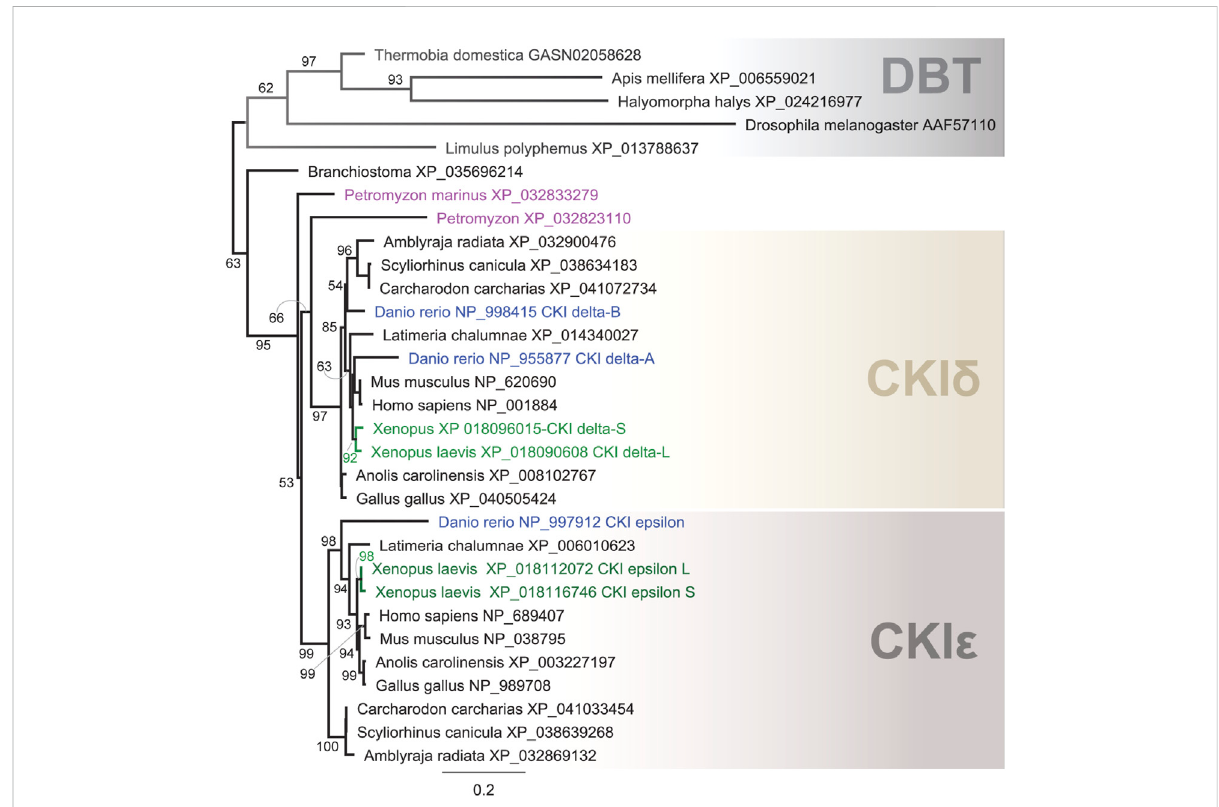
FIGURE 4 Phylogeny of DBT, CKI δ , and CKI ε indicates several gene duplications in vertebrates. In the lancelet Branchiostoma , only one CKI gene was found to precede the δ - and ε -isoforms. The major duplication that gave rise to the δ and ε isoforms dates back to the ancestor of Gnatostomata (vertebrates with jaws), while two CKI genes in the sea lamprey Petromyzon marinus resulted from Petromyzon -speci fi c gene duplication. CKI δ was duplicated in the zebra fi sh Danio rerio , resulting in the so-called CKI δ -A and CKI δ -B. In the African clawed frog Xenopus laevis , a large genome duplication resulted in two CKI δ (L and S) and CKI ε (L and S) genes. DBT sequences from protostomian representatives (the fi rebrat Thermobia domestica , the honey bee Apis mellifera , the marmorated sting bud Halyomorpha halys , the fruit fl y Drosophila melanogaster , and the